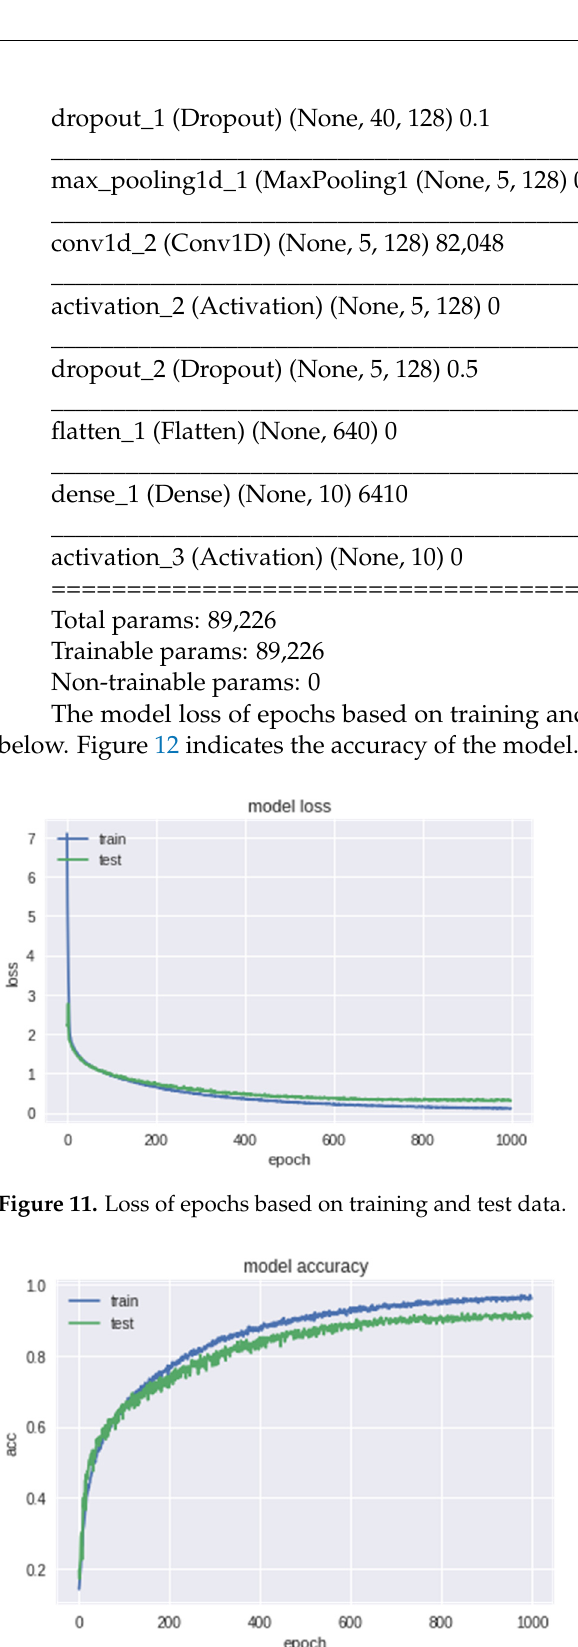
the SVM, LSTM, and RNN-LSTM approaches with an accuracy of 76%, 82%, and 91%, respectively. The confusion matrix displayed in the Figures 13–15 below is the